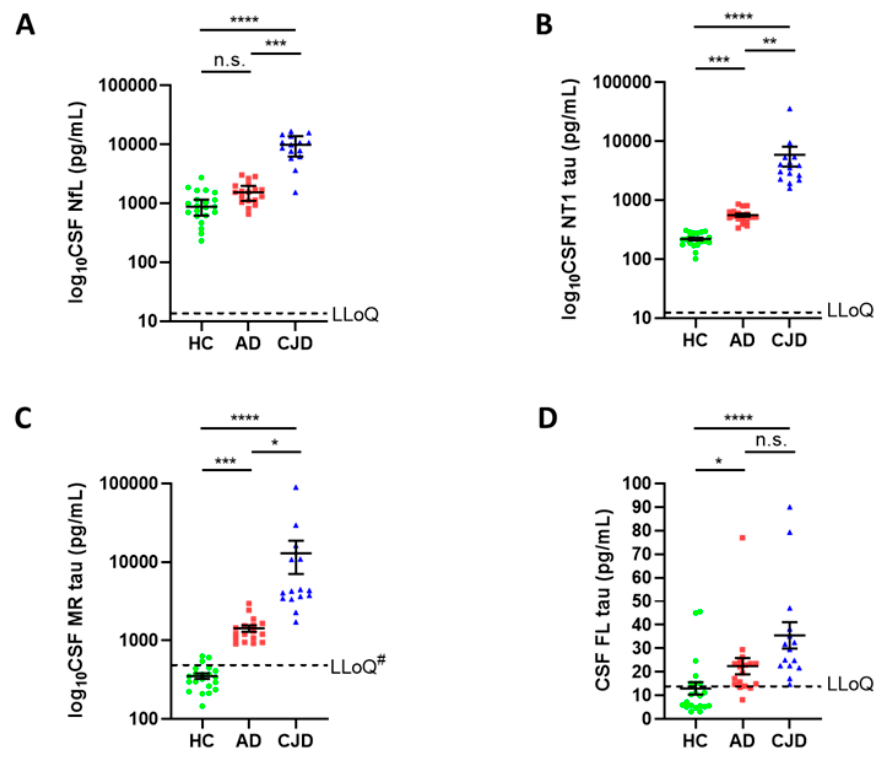
Figure 2. CSF NfL and forms of tau measured with NT1, mid-region and full-length assays are increased in CJD compared to AD and controls. Study 1 CSF samples comprise 21 HC (green circles), 18 AD (red squares) specimens collected in Gothenburg, and 15 CJD (blue triangles) samples collected at UCL. All samples were treated with GuHCl, diluted as required and analyzed with Simoa-based assays for ( A ) NfL, ( B ) NT1-tau (BT2-Tau12), ( C ) MR-tau (BT2-ADx202), and ( D ) FL-tau (TauAB-Tau12). Each point represents a single individual and means ± SEM are indicated. Differences between groups were assessed with Kruskal–Wallis H test followed by Dunn’s post-hoc test. CSF NT1, MR, and FL-tau was elevated in AD versus controls, whereas NfL only showed a trend towards elevation in AD compared to controls. CSF levels of NfL, NT1, and MR-tau were strongly increased in CJD versus AD and controls, whereas FL-tau levels were only modestly higher in CJD. #MR-tau levels in CJD, AD and NC samples were measured in the presence of 0.063 M GuHCl, but samples were diluted 1:4 for NC and AD, and 1:80 for CJD samples. Therefore, the actual LLoQ for the AD and NC samples was ~27 pg/mL versus 536 pg/mL for the CJD samples. One CJD patient and one AD patient had MR-tau measurements above the upper limit of quantitation. Abbreviations: